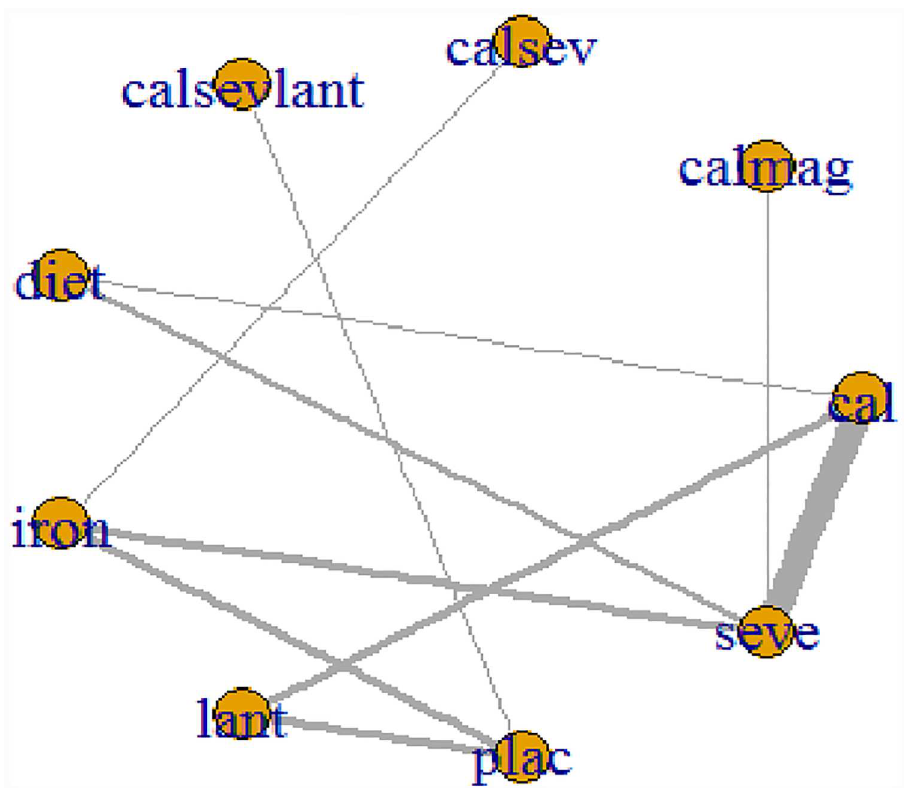
Fig 3. Network of clinical trials of phosphate binders in patients with chronic kidney disease: outcome mean change from baseline in serum phosphate concentration. Netplot of effectiveness outcome for mean phosphate reductionat the end of the study period. Network of randomizedcontrolled trials comparing different phosphate binders for mean change in serum phosphate. Lines connectdifferent phosphate bindercategorieswith direct evidence.The width of lines correlatesthe number of RCTs for each direct comparisonwhile the size of the nodescorrelateswith the total sample size. Abbreviations: cal: calcium; calmag: calcium and magnesium;calsev: calcium and Sevelamer; calsevlant:calcium or sevelamer or lanthanum;lant: lanthanum; seve: